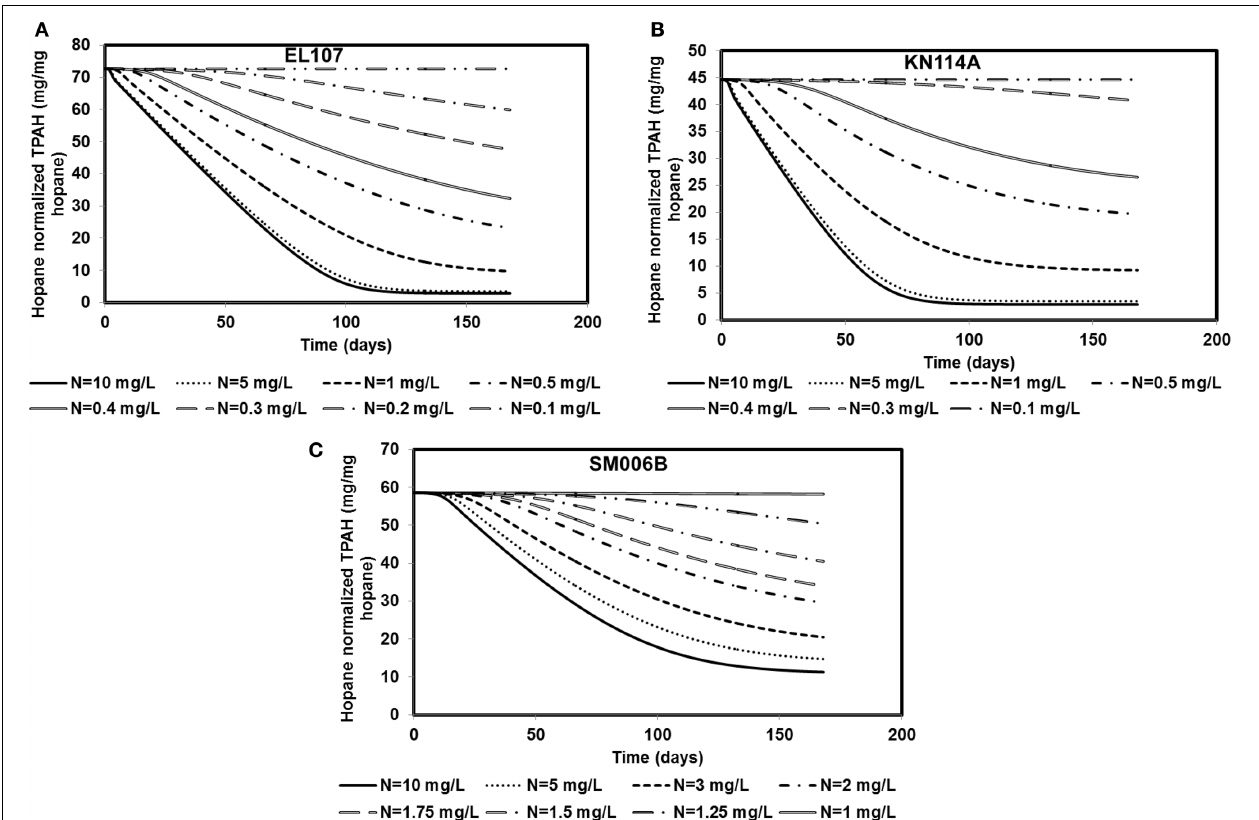
FIGURE 5 | Sensitivity of the numerical model to nutrient concentration for (A) EL107, (B) KN114A, (C) SM006B. Note that SM006B location has slower biomass growth rate and hence it is more sensitive to nutrient concentration.